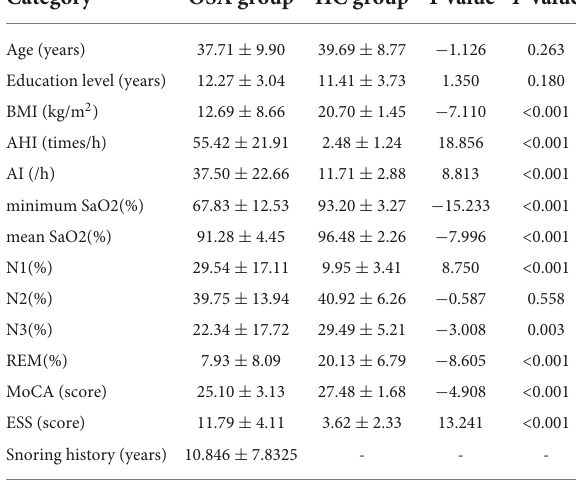
TABLE 1 Demographics statistics and clinical indicators of the OSA and GS groups (X ± SD).